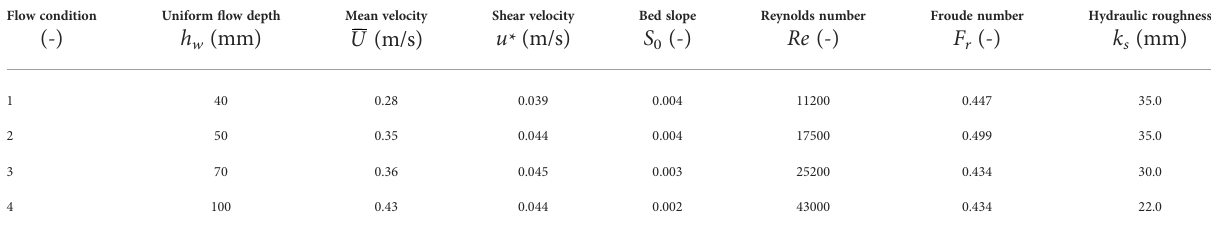
TABLE 1 Summary of the experimental fl ow conditions.